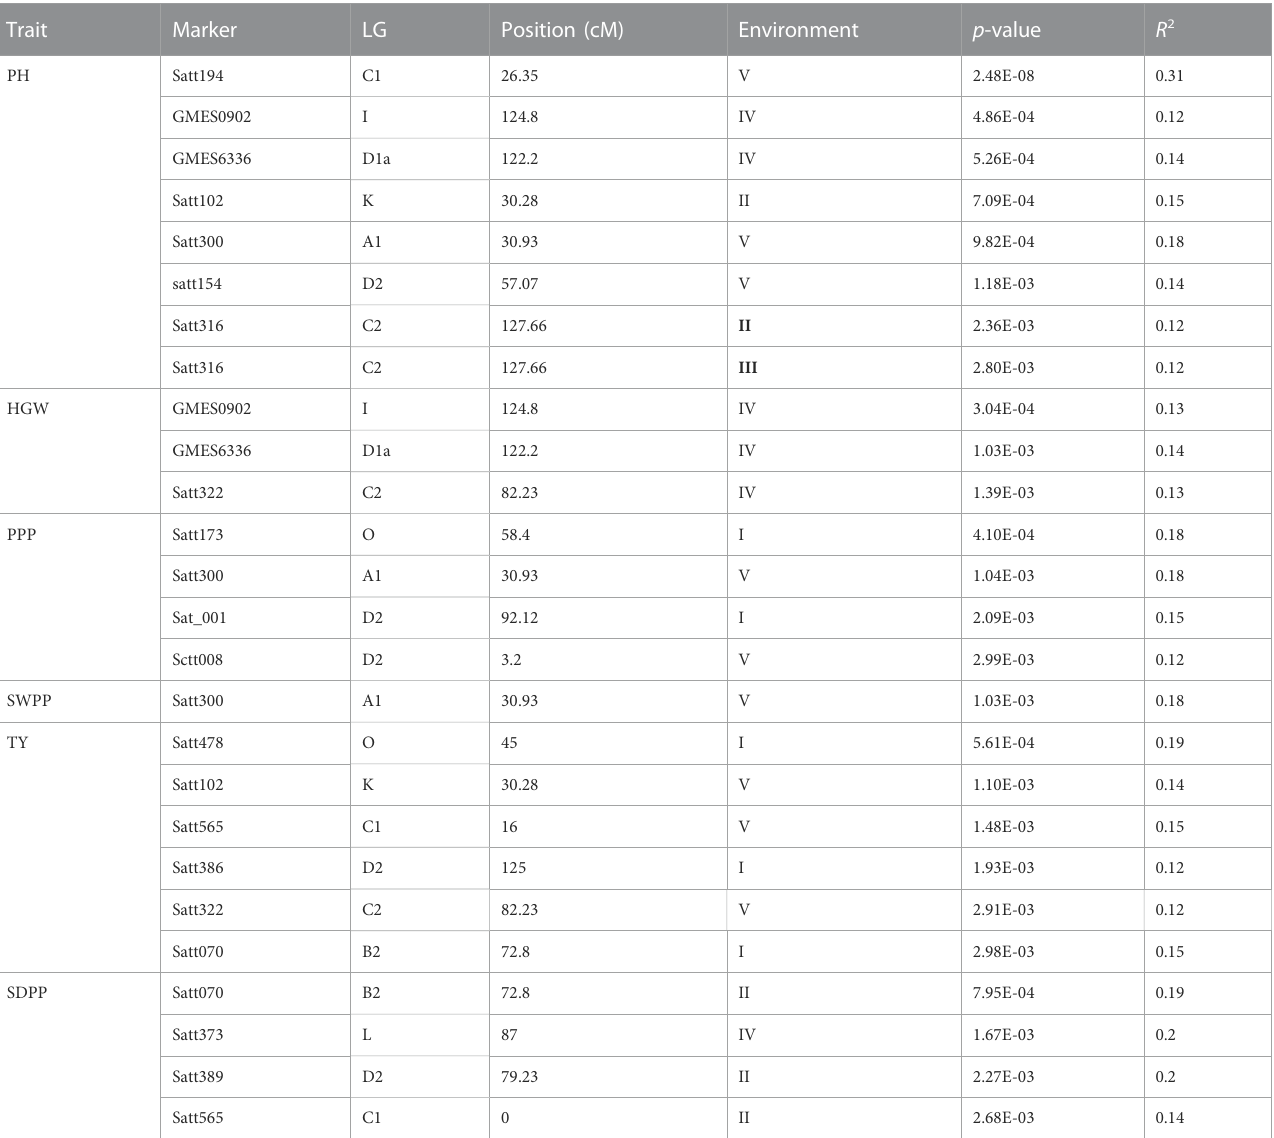
TABLE 5 Marker – trait associations detected using GLM with six traits. Trait